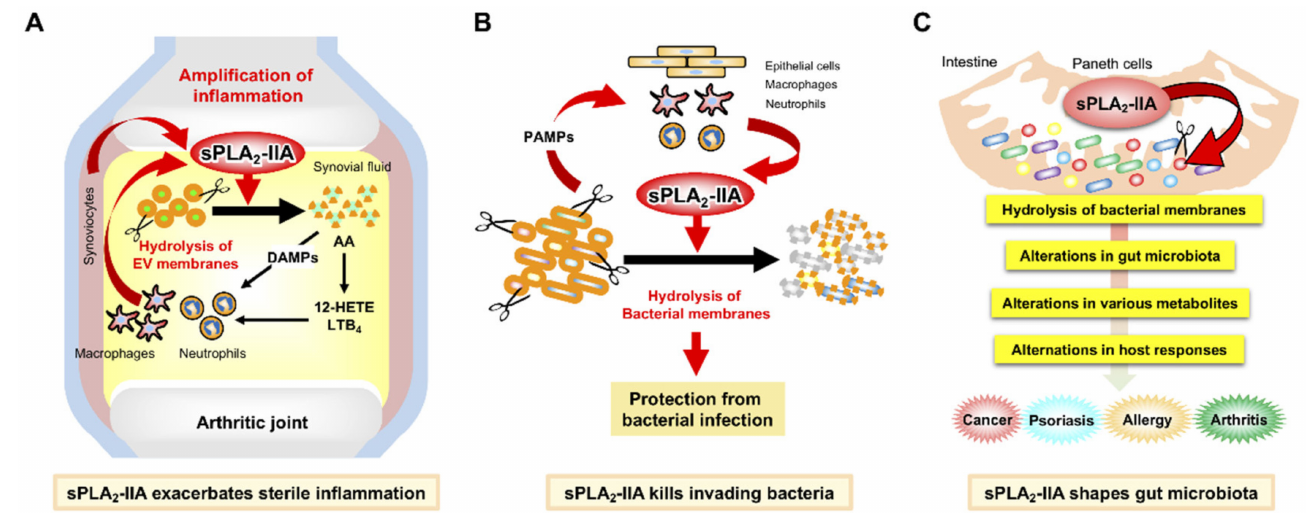
Figure 1. Functions of sPLA 2 -IIA in sterile inflammation, anti-bacterial defense, and microbiota regulation: ( A ) In human rheumatoid arthritis, sPLA 2 -IIA induced in leukocytes and synoviocytes by inflammatory cytokines acts on phospholipids in EVs to release AA, which is further metabolized to eicosanoids such as 12-hydroxyeicosaenoic acid (HEPE) and leukotriene B 4 (LTB 4 ) to promote neutrophil recruitment and activation. sPLA 2 -IIA also releases mitochondrial DNA, one of the danger-associated molecular patterns (DAMPs), from the EVs. As such, sPLA 2 -IIA amplifies sterile inflammation as an “inflammatory sPLA 2 ” [10,32]. ( B ) During bacterial infection, sPLA 2 -IIA induced in various cells (such as epithelial cells and leukocytes) by pathogen-associated molecular patterns (PAMPs) (such as peptidoglycan and lipopolysaccharide) kills invading bacteria by degrading bac- terial membranes. As such, sPLA 2 -IIA plays a role in host defense against bacterial infection as a “bactericidal sPLA 2 ” [20,33]. ( C ) In the intestinal lumen, sPLA 2 -IIA secreted from Paneth cells acts as an antimicrobial protein to shape the gut microbiota, thereby secondarily affecting host responses including cancer, psoriasis, allergy, and arthritis (see